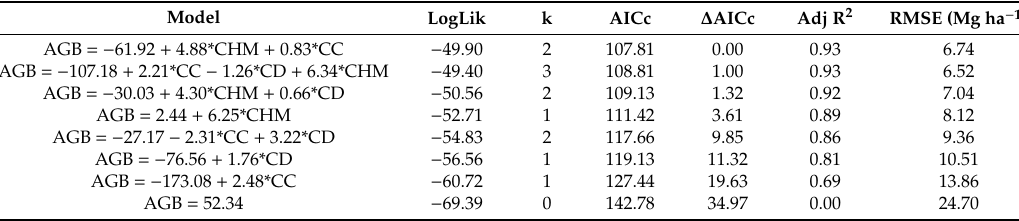
Table 3. Model comparison according to Akaike’s information criterion corrected for a small sample size (AICc). Parameters for each model include: LogLik (log-likelihood), k (number of predictor variables), AICc (Akaike’s information criterion corrected for a small sample size), ∆ AICc (di ff erence in AICc between the current and the best model), Adj R 2 (adjusted coe ffi cient of determination), and RMSE (root mean square error). The intercept and coe ffi cients, as well as the coe ffi cient of determination (R 2 ) for each model, are also presented. CHM = canopy height model, CD = canopy density, and CC = canopy cover.